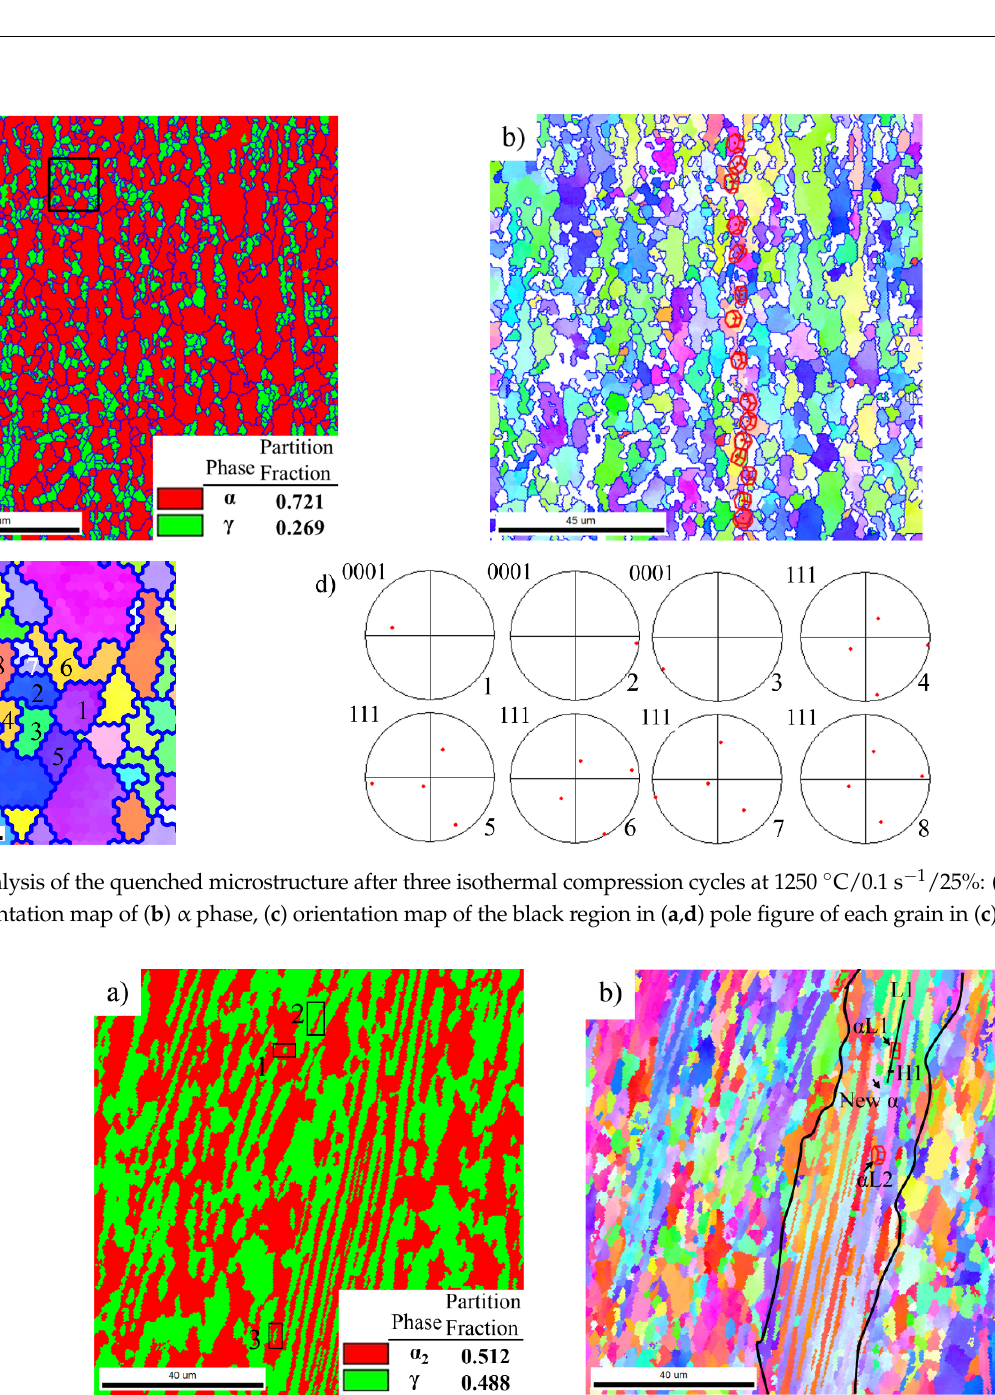
Figure 4. EBSD analysis of quenched rolled Ti-44Al-8Nb-(W, B, Y) alloy: ( a ) phase map and ( b ) orientation map.